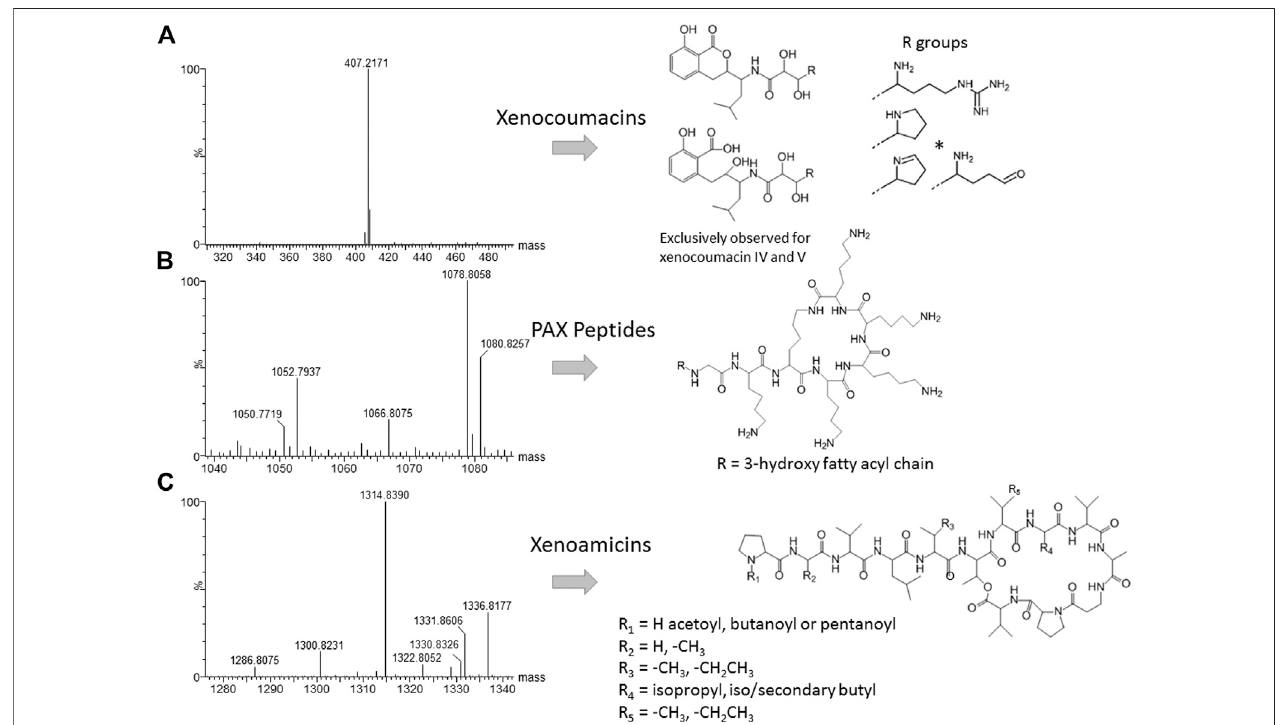
FIGURE6| HighresolutionMSanalysisand thestructuresofcompounds inthethreemostprominentknownfamiliesidenti fi edinJ194culture: (A) Xenocoumacin II, identi fi ed with a * (McInerney et al., 1991b; Reimer et al., 2009); (B) PAX peptides (Fuchs et al., 2011; Dreyer et al., 2019), and (C) xenoamicins (Zhou et al., 2013 and this study). Refer to Supplementary Figure S6, S7 for more structural analyses details.